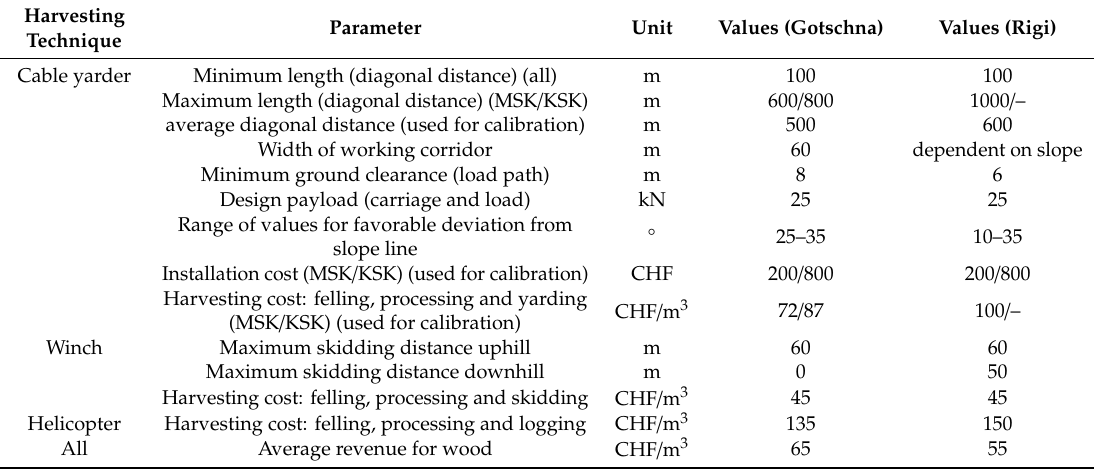
Table 3. Parameters of the harvesting techniques. (MSK: short distance yarder, KSK: long distance yarder). Harvesting